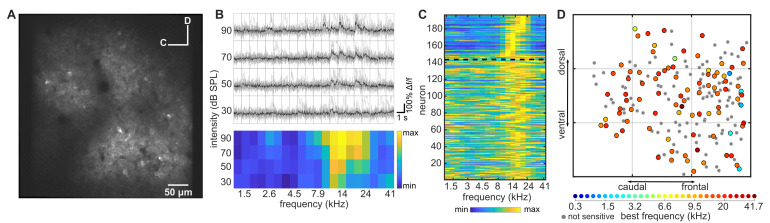
Imaging neuronal responses to pure tones in ferret A1.(A) An example cortical field in A1 of ferret 1, imaged 120 µm below the pial surface. (B) Responses of one neuron in (A) to pure tones presented at different frequencies and sound levels. Top panel: single trial (gray) and trial-averaged (black) ΔF/F0 traces, measured for 1 s from sound onset. Bottom panel: Frequency Response Area (FRA) of the same neuron. Color scale indicates the trial-averaged response of the neuron to tones presented at each frequency/level combination, calculated from the deconvolved fluorescence trace (see Materials and methods). (C) Frequency-response profile (i.e. level-averaged tuning curves) of all neurons in (A). Neurons above the dashed black line were significantly modulated by frequency (two-way ANOVA, p<0.05) and are sorted by their Best Frequency (BF). Neurons below the line were not sensitive to sound frequency and are sorted by the p-value of the frequency predictor in the two-way ANOVA (bottom neurons have the largest p-value). (D) Map of the neurons in (A) color-coded according to their BF (see color scale below). Gray dots represent neurons that were not sensitive to tone frequency. Each gray grid is 100 µm2.